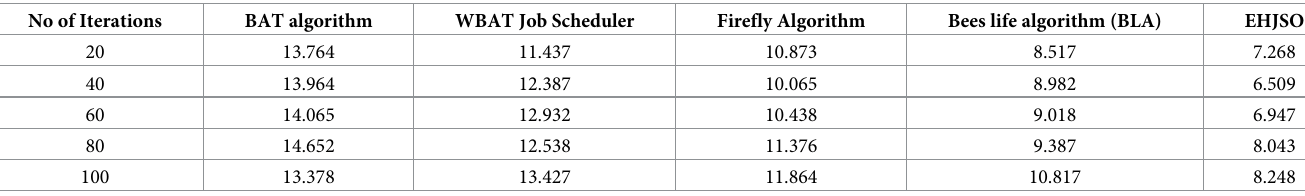
Table 4. Fitness analysis for EHJSO method with existing